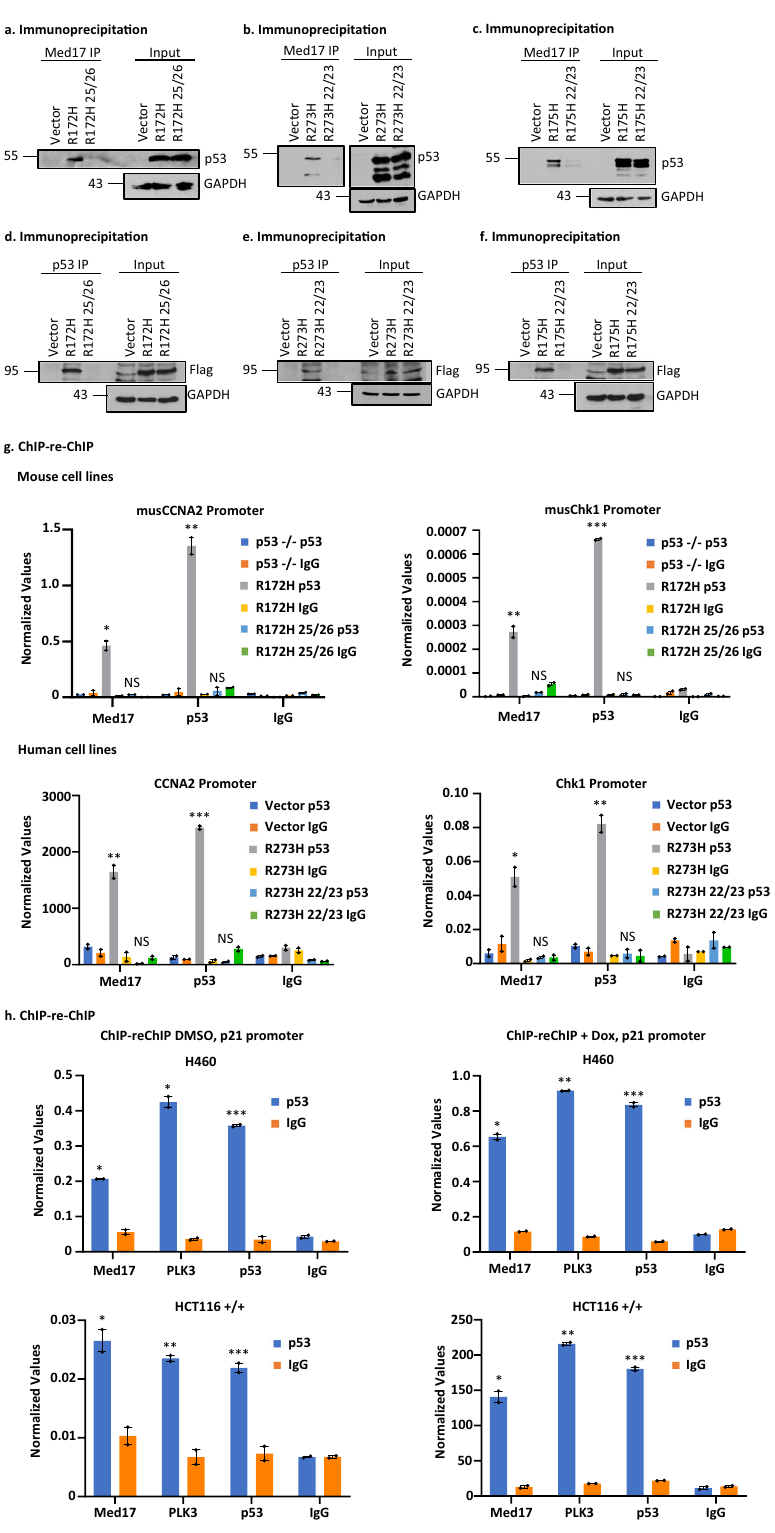
mutants with intact TAD (Fig. 6b, c) and obtained similar data substitution mutants of p53-R273H in H1299 p53-null lung showing S20 phosphorylation is affected by TAD mutations. cancer cells. We found that S20A substitution has the most To test whether phosphorylation at different amino acid profound effect in reducing the transactivation ability, suggesting positions is required for GOF p53-mediated transactivation, we that phosphorylation at amino acid position 20 is important for generated a number of alanine (Ala) substitution mutants (S6A, transactivation by mutant p53. If the purpose of phosphorylation S9A, S15A, and S20A). Figure 6d shows NF- κ B2 promoter is merely to increase the negative charge of GOF p53, it would be transactivation data obtained by co-expression of different Ala predicted that substitution of S20 with the negatively charged NATURE COMMUNICATIONS| (2021) 12:704